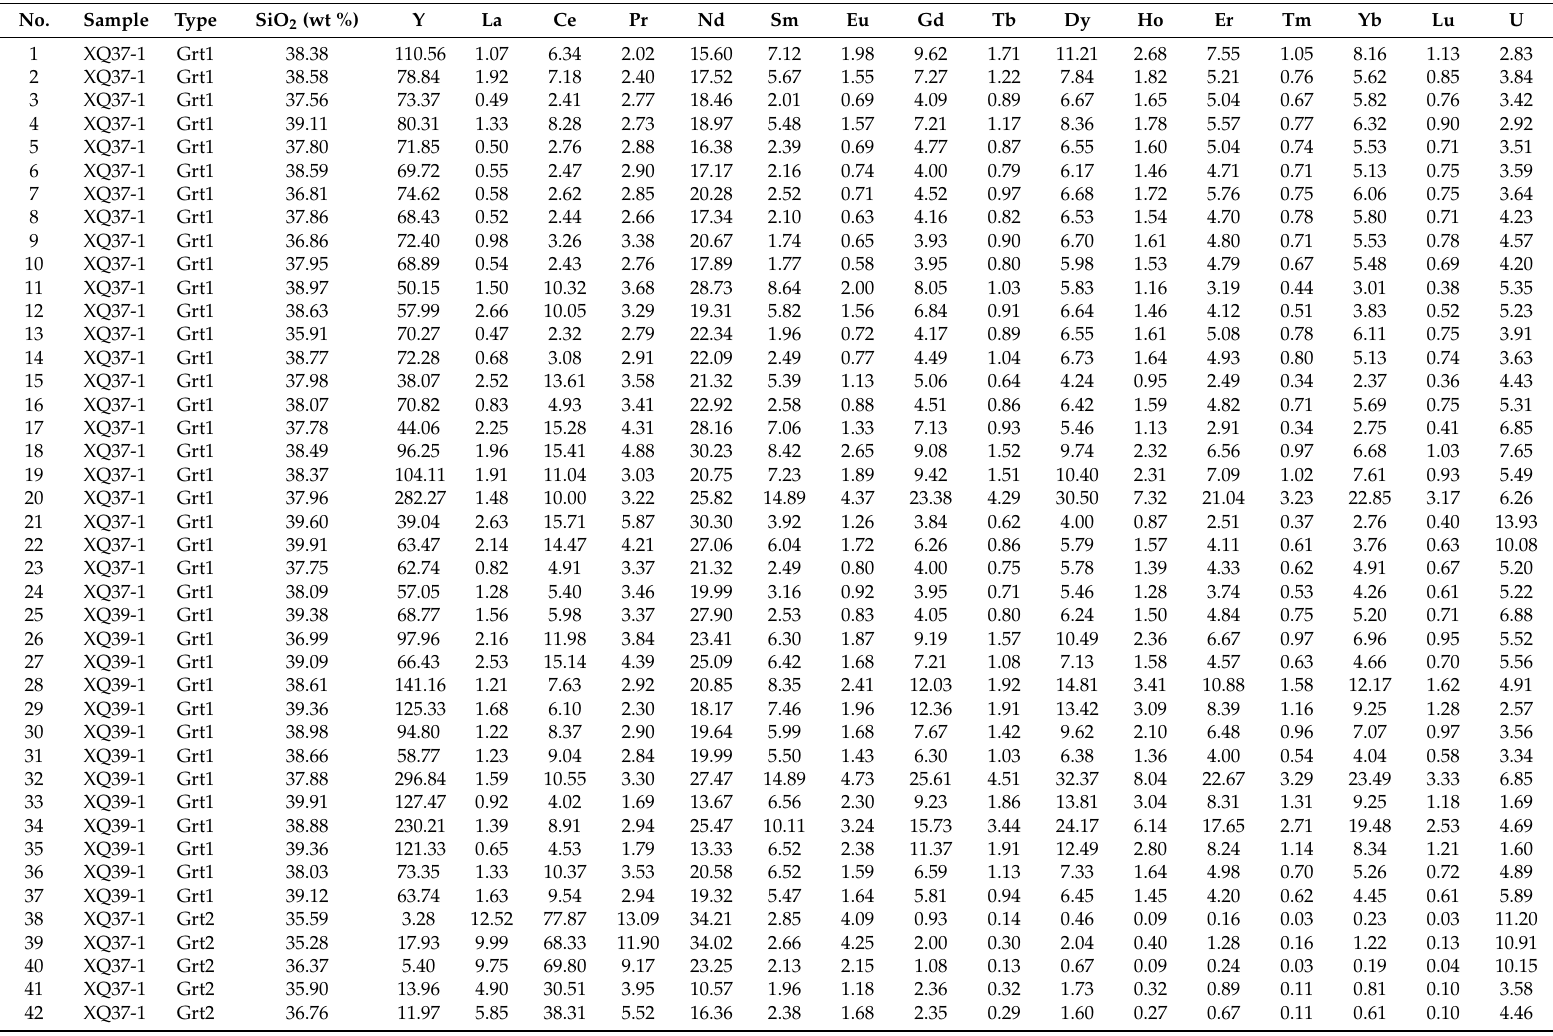
Table 1. Laser ablation (LA)-ICP-MS trace elements data (ppm) of the Xinqiao